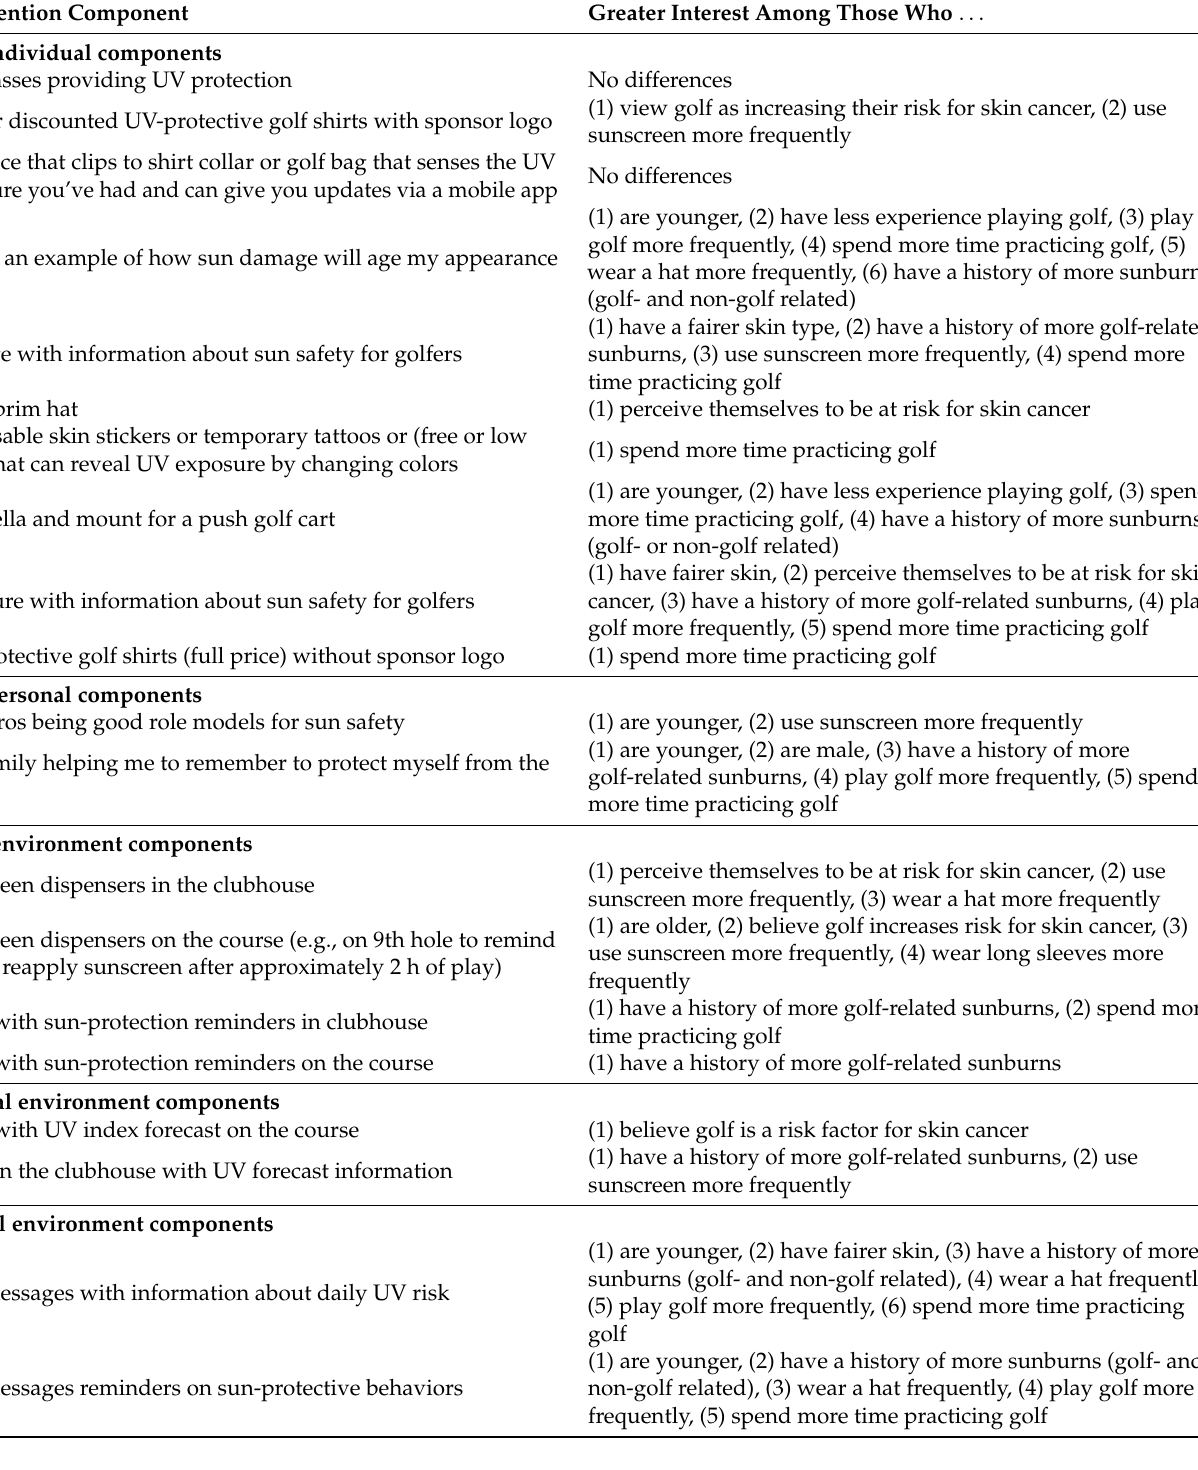
Table 4. Golfers’ interest in components of a sun-safety intervention. Greater Interest Among Those Who . .